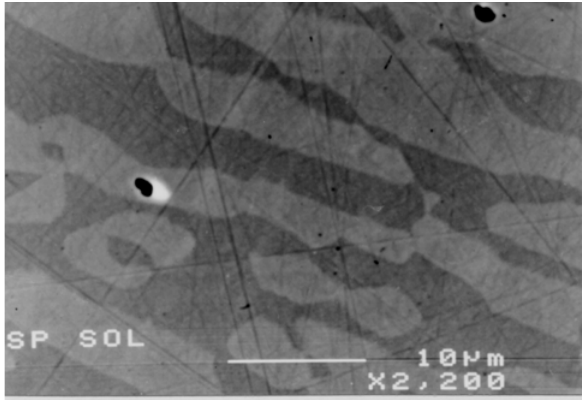
Figure 5. Corrosion pits (black spots) nucleated on austenite of the solution annealed AV2205 alloy after the cyclic potentiodynamic polari- zation test. SEM - primary electrons image. 2200X. Table 12. The pitting percentage in three different locations, for the four solution annealed alloys.